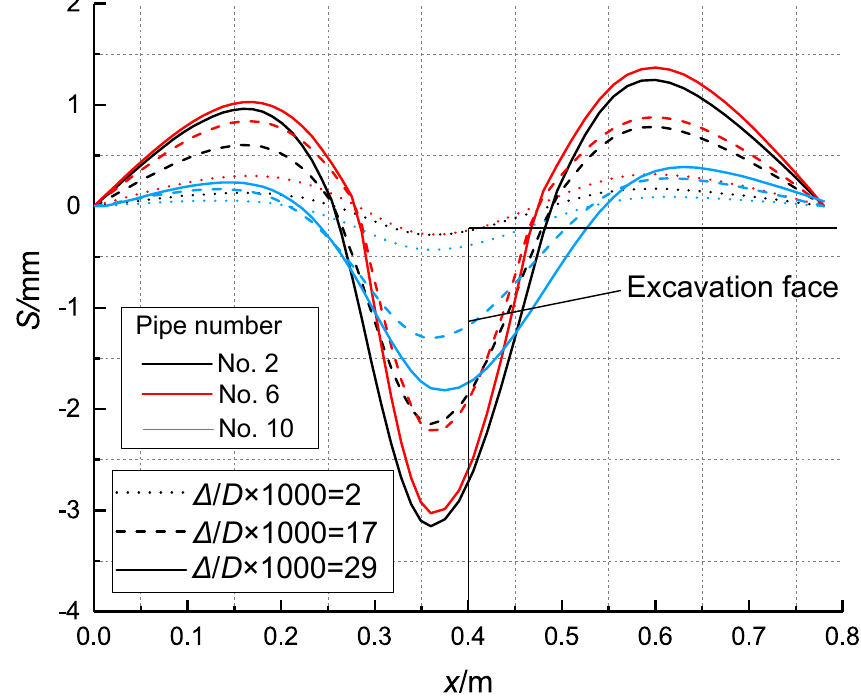
Figure 13. Deformation of pipe roof for three levels of the excavation face displacement ( EI